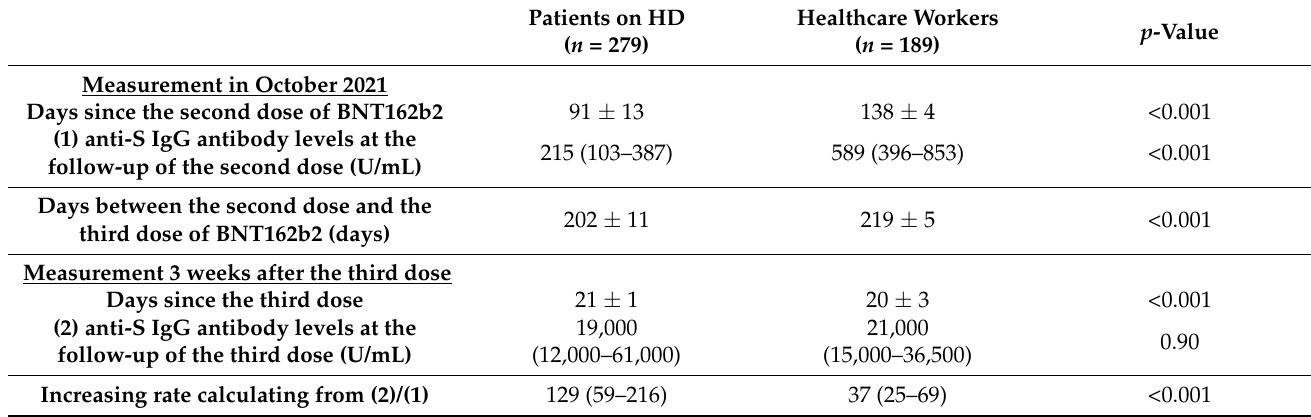
Table 2. Humoral response to BNT162b2 vaccination in terms of anti-spike immunoglobulin G antibody levels.